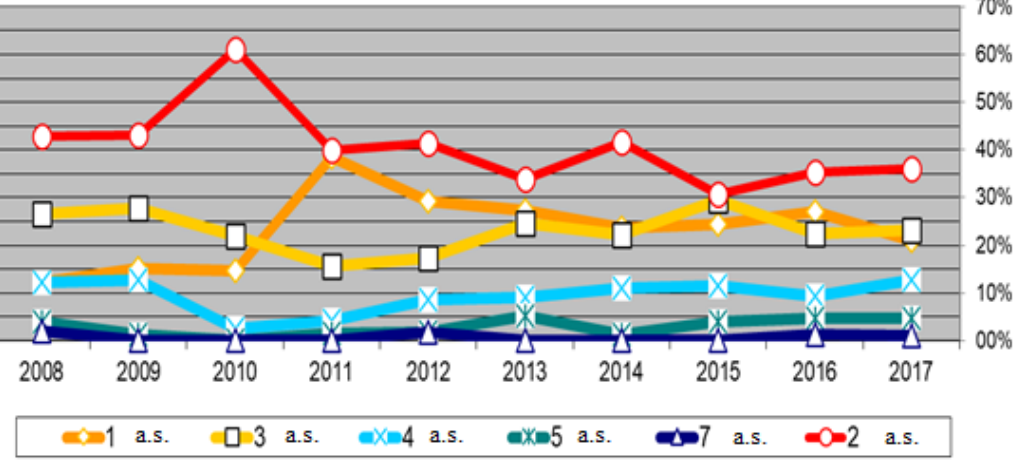
Figure 1. Number of active substances (a.s.) per sample .